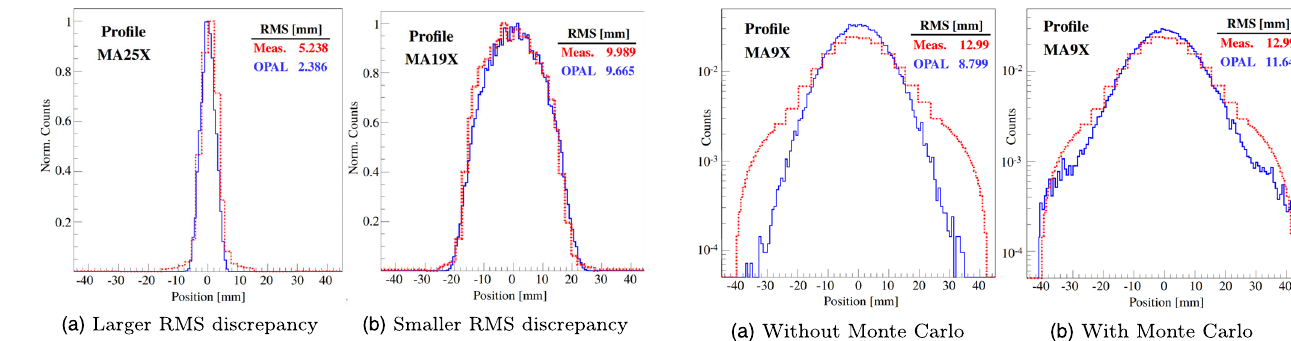
FIG. 11. Comparison between the measured profile and the particle distribution from OPAL with and without the Monte Carlo routine for the particle-matter interaction applied on the colli- mators ahead of the monitor